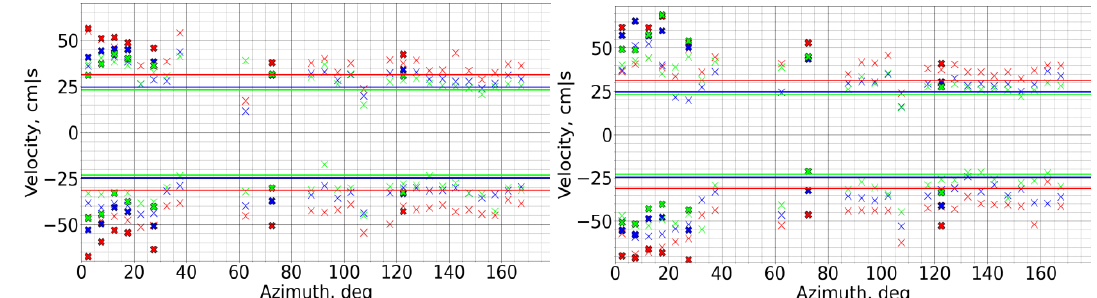
Figure 10. Velocities of BC (left) and NBC (right) scatterers (red crosses 3 GHz, blue — 6 GHz, green −10 GHz at wind velocities about 6 m/s, colored squares— for wind velocities 10 – 11 m/s).